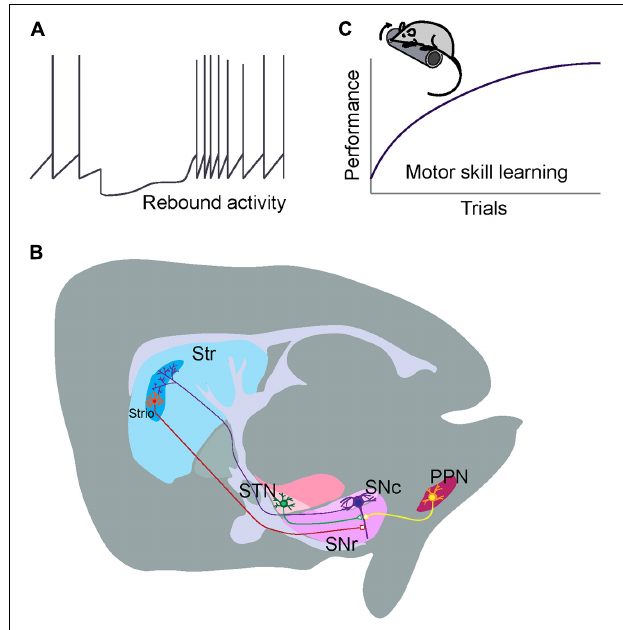
FIGURE 3 | Distinct electrophysiology, connectivity, and functionality of ALDH1A1 + nDANs. (A) Rebound activity of ALDH1A1 + nDANs following dSPN inhibition. (B) Major inhibitory and excitatory presynaptic inputs to the ALDH1A1 + nDANs. (C) A critical involvement of ALDH1A1 + nDANs in regulating the vigor of movement during the acquisition of motor